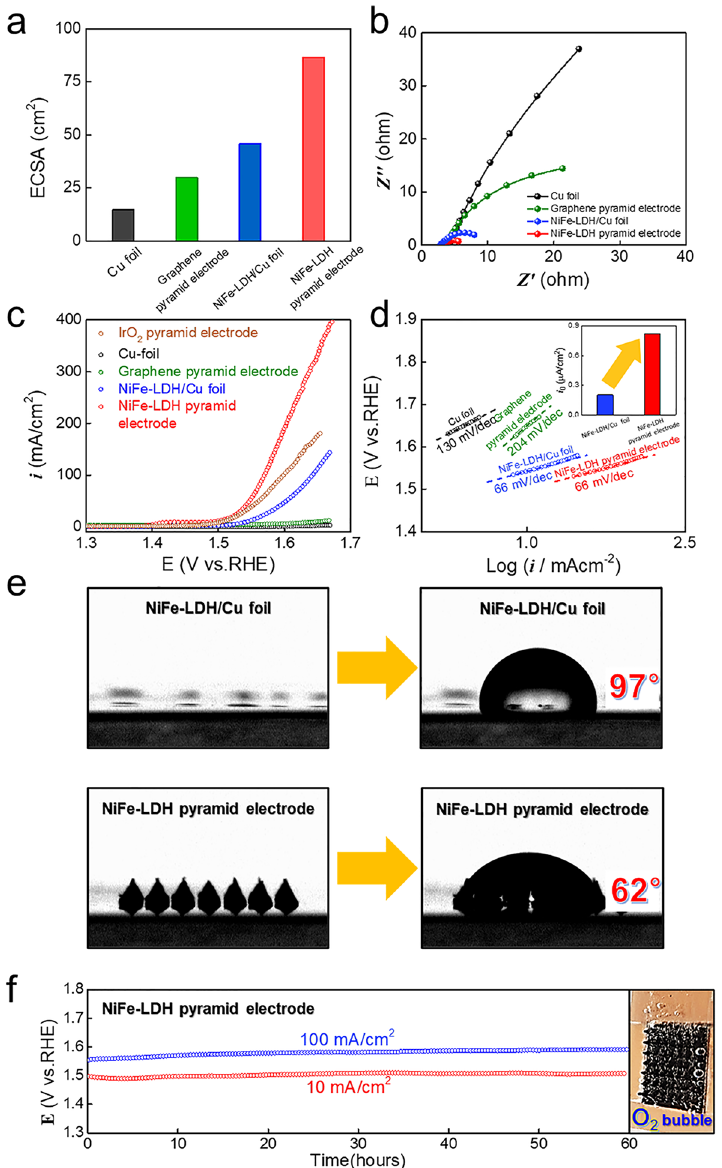
Figure 5. Electrochemical analysis for OER. (a) ECSA calculated from double layer capacitance. (b) Electrochemical impedance spectroscopy of Cu foil (black), graphene pyramid electrode (green), NiFe-LDH/Cu foil (blue) and NiFe-LDH pyramid electrode (red) at 1.58 V RHE . (c) 85% iR-corrected polarization curves of IrO 2 on pyramid electrode (brown), Cu foil (black), graphene pyramid electrode (green), NiFe-LDH/Cu foil (blue) and NiFe-LDH pyramid electrode (red) in 1 M KOH. (d) Tafel plots obtained from iR-corrected polarization curves with exchange current density (inset). (e) Wettability of NiFe-LDH pyramid electrode and NiFe-LDH/Cu foil. (f) Durability test of NiFe-LDH pyramid electrode at 10 (red) and 100 (blue) mA/cm 2 for 60 h with 85% iR